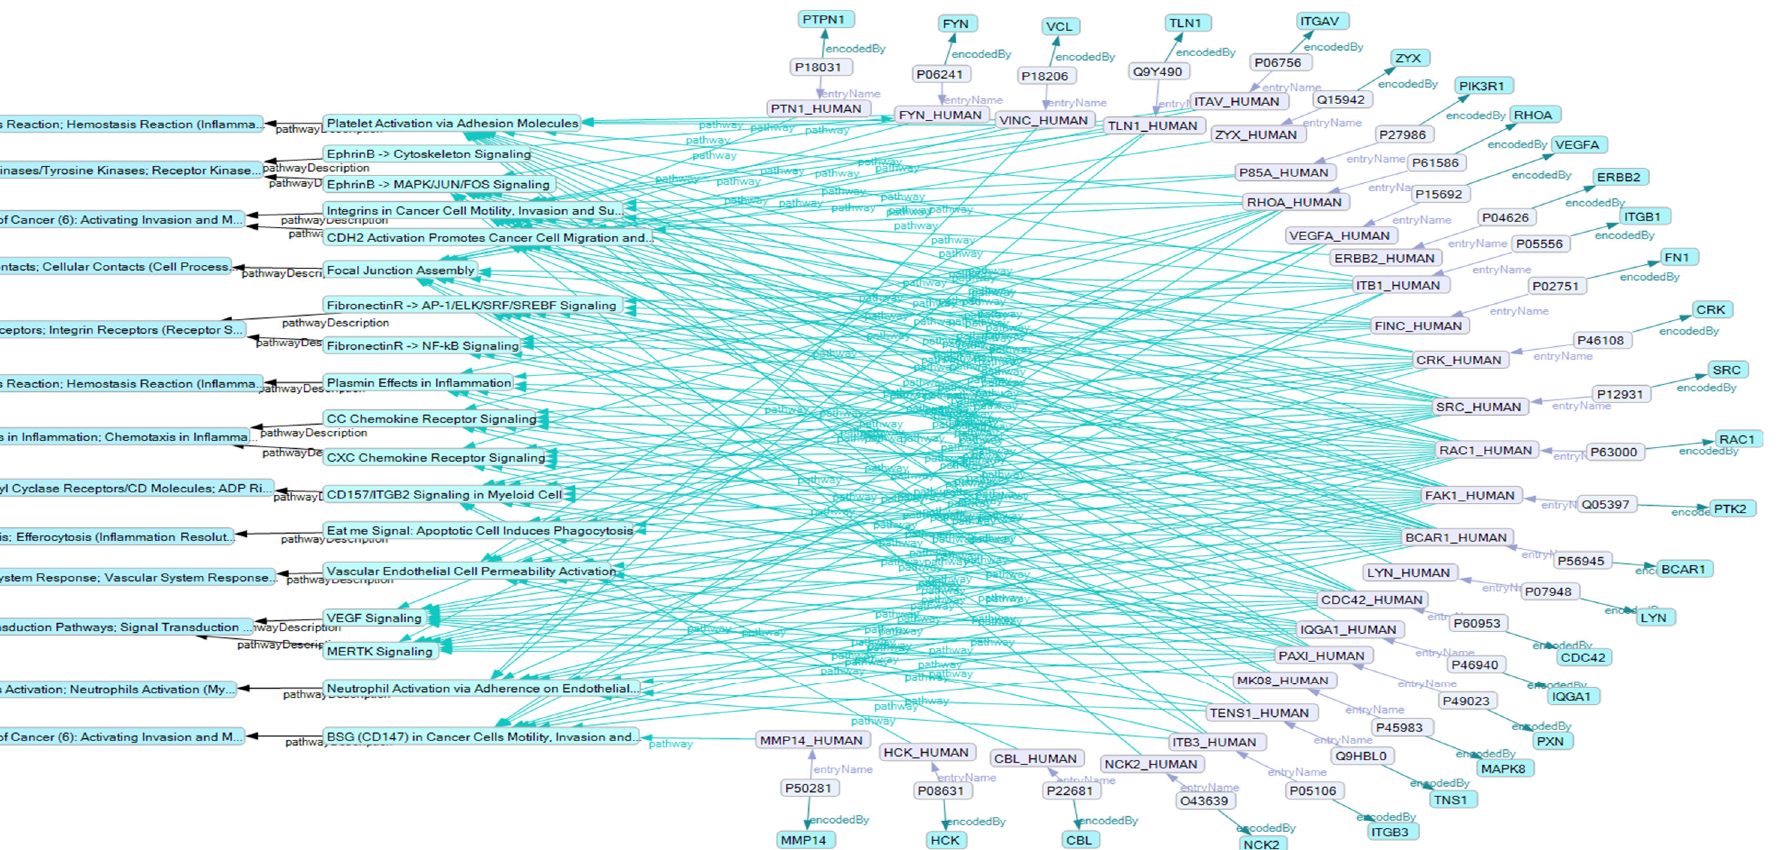
Figure 5. Overview on the participation of selected proteins in signaling pathways and processes. Proteins are identified by SwissProt accession numbers (AC#) and gene names shown at the right side of the figure. The arrows indicate participation of a protein in the pathway indicated within blue rectangles at the left side of the figure. The very left column shows the name of the group to which, according to Reactome, the pathways mentioned in the second column from left belong. (For further details, see Supplementary Table S1, or zoom in) .